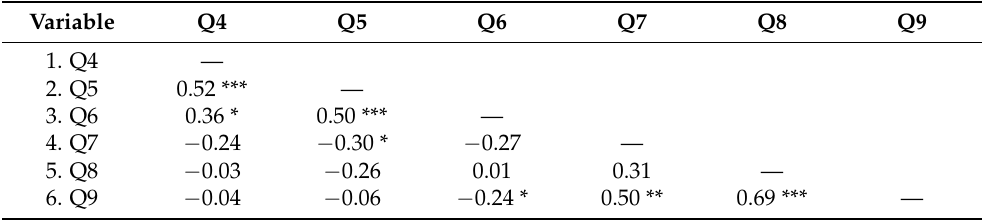
Table 4. Kendall’s τ correlations concerning the answers to the questions on psychological distress and work environmental factors by physical therapists involved in the C.A.L.A.B.R.I.A. study ( n = 80). Variable Q4 Q5